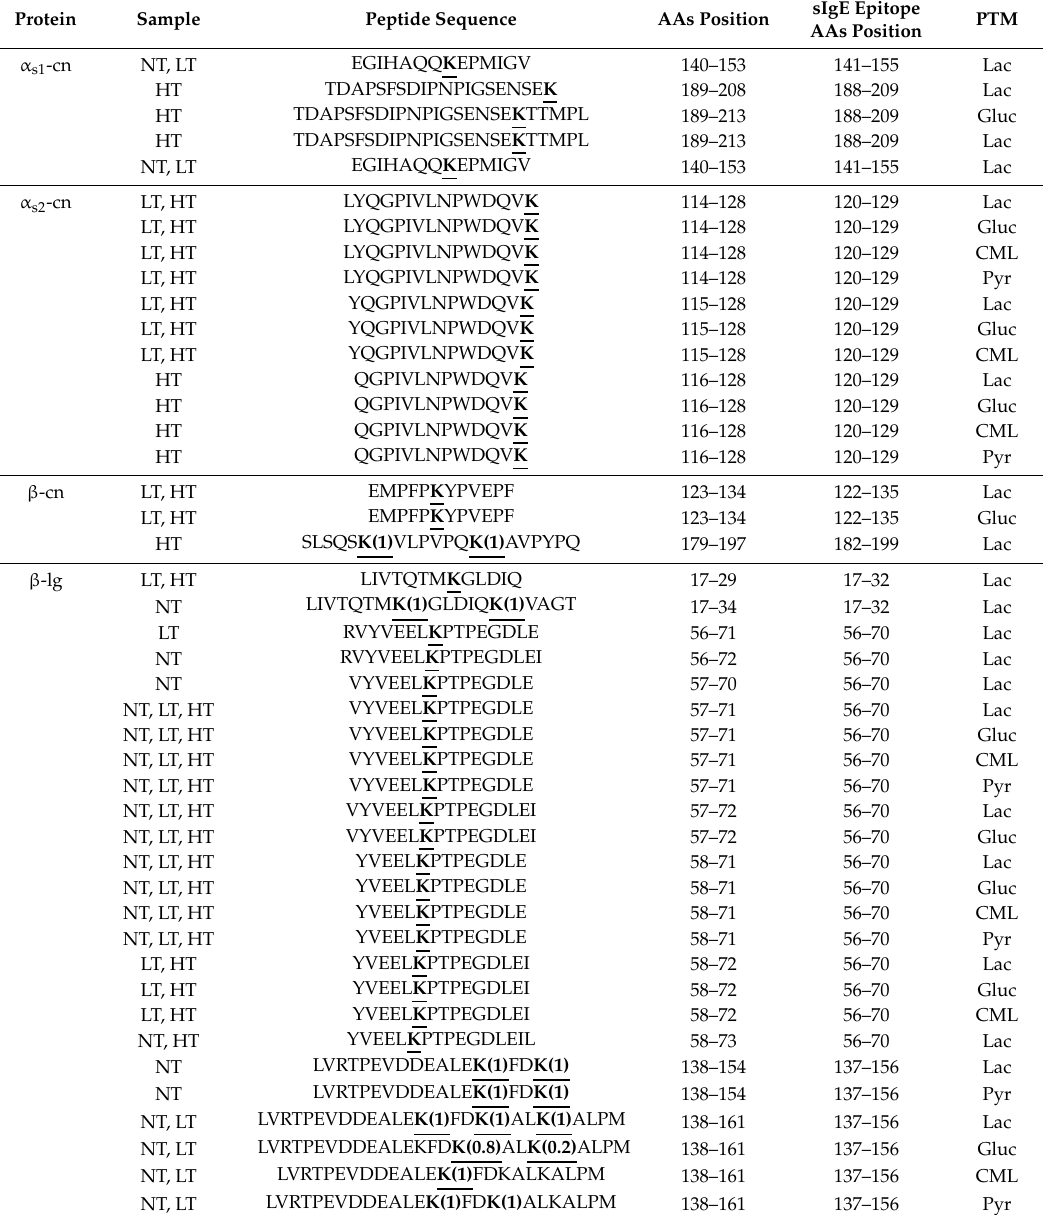
Table 2. sIgE binding epitopes 1 identified in glycated digestion-derived peptides after 10 min in the intestinal phase. Peptides were identified in cow’s milk protein, non-treated (NT), heated at low temperature (LT), and heated at high temperature (HT), after simulated infant in vitro digestion and derived from casein (cn) and β -lactoglobulin (lg). Amino acids (AAs) position indicates the position within the proteins including the signal peptide. Peptides containing post translational modification (PTM) to lactosyl lysine (Lac), glucosyl lysine (Gluc), N ε -carboxymethyllysine (CML), and pyrroline (Pyr) on lysine (K) are indicated, and modified K residues are highlighted in bold and underlined with modification site probability given in brackets if multiple options were